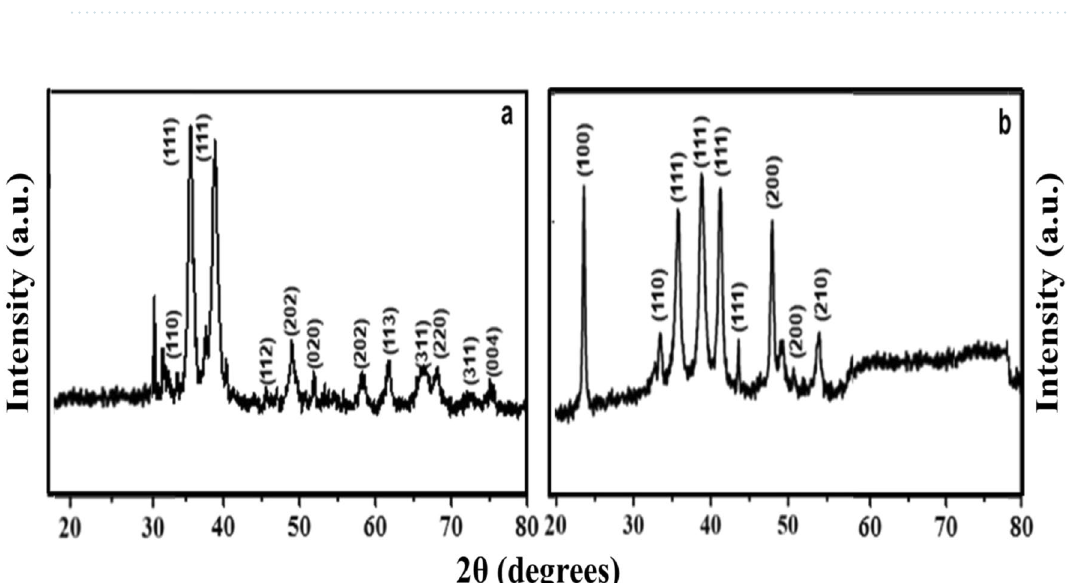
Figure 3. X-ray diffraction spectrum of the synthesized Cu 3 N nanoparticles at ( a ) 60 ml/min and ( b ) 120 ml/ min ammonia flow